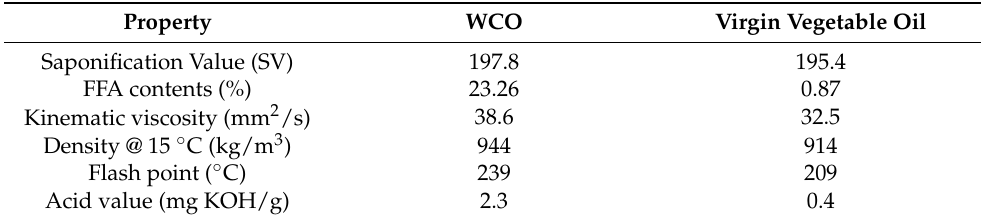
Table 1. The WCO and Virgin oil properties.